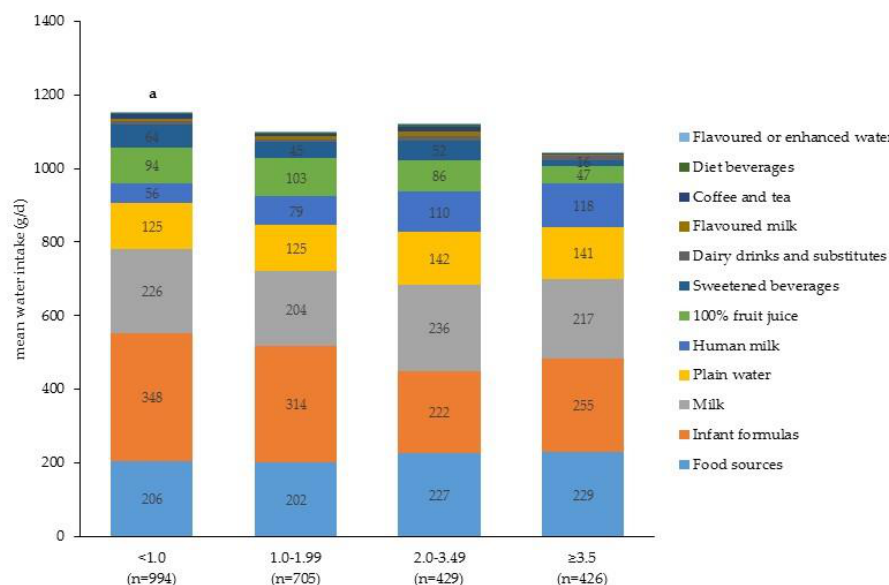
Figure 6. Per capita daily intake of water (g/day) from beverage and food sources by poverty–Income ratio ( n = 2554) 1 . 1 Wald F -test to assess overall group difference in daily mean intake (g/day) of water p < 0.01; Independent T -test with Bonferroni adjustment for multiple comparisons was used to assess differences between each sub-group. Sub-group differences indicated by: a PIR < 1.0 vs. PIR ≥ 3.5, p <